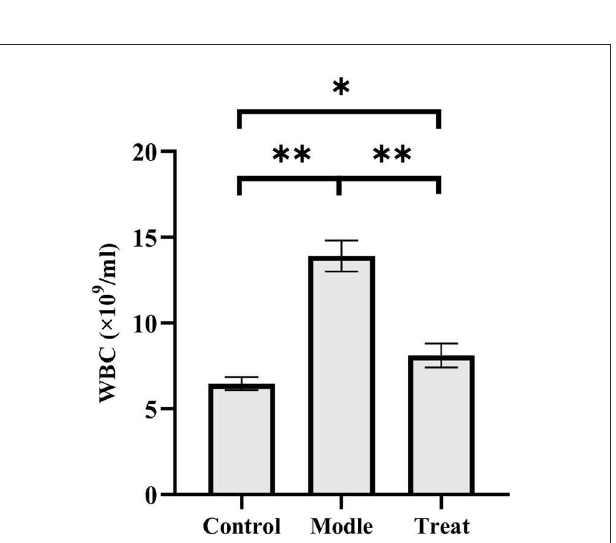
FIGURE2 Examination results of white blood cells in rabbit blood. Bar graphs show the mean results ± SD ( n = 3), * P < 0.05, ** P < 0.01.